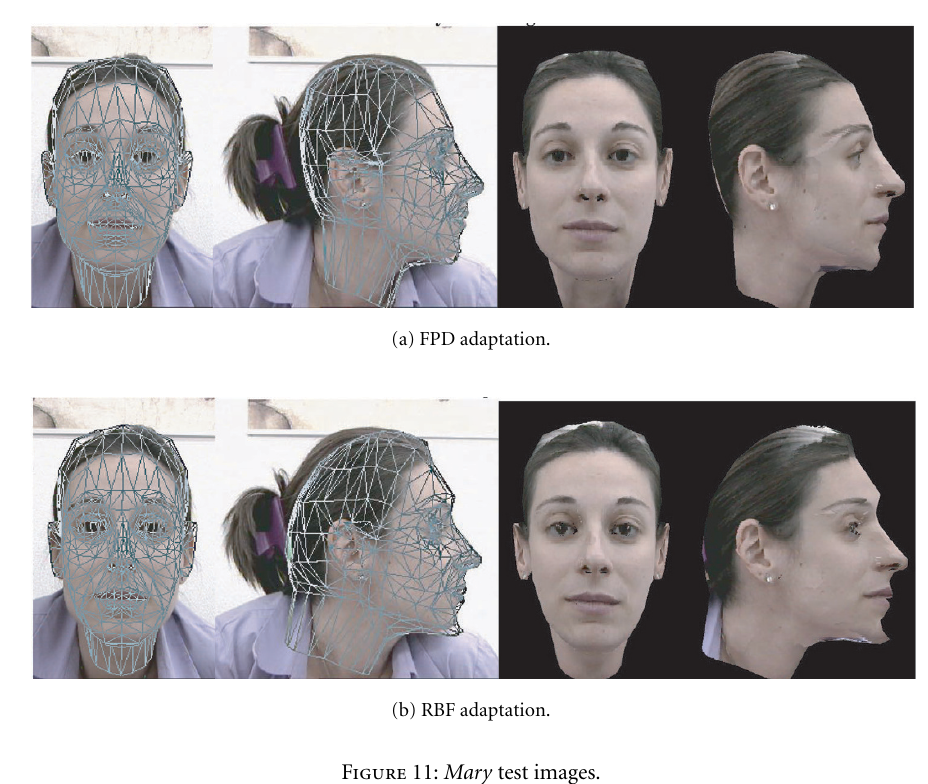
Figure 11: Mary test images.